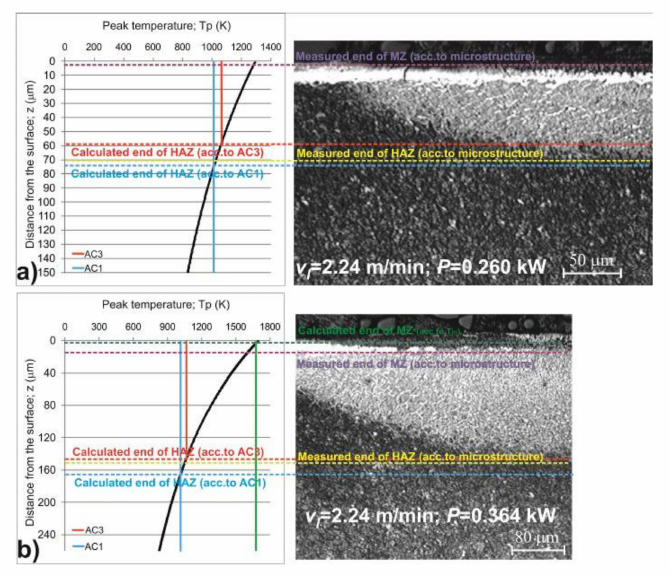
Figure 5. Temperature distribution along the axes of laser tracks and related microstructures after laser modification of gas-nitrided layer using scanning rate v l = 2.24 m · min − 1 and P = 0.260 kW ( a ) or P = 0.364 kW ( b